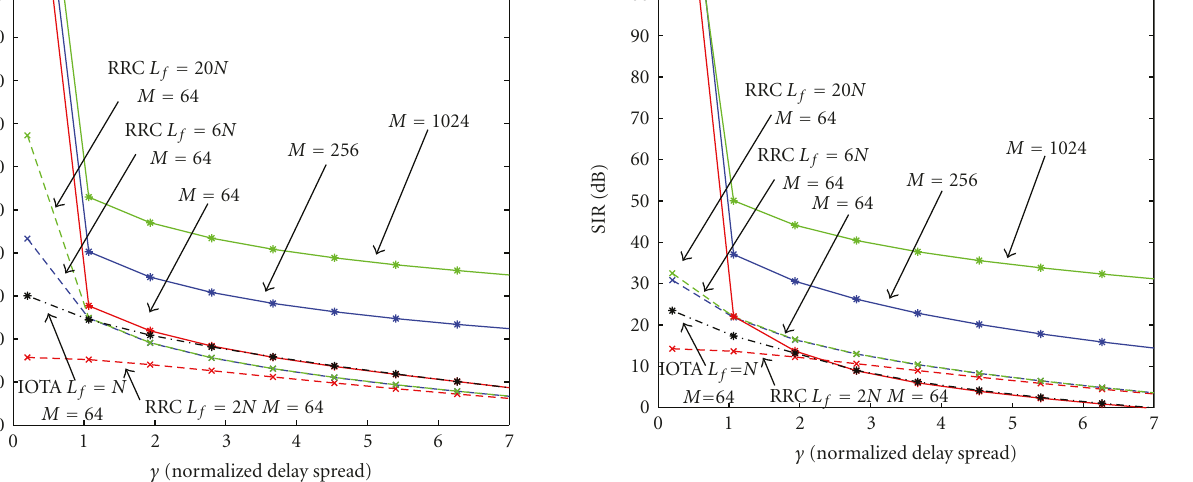
Figure 13: SIR versus the normalized delay spread γ for orthogonal pulse (solid lines) with M 0 = 2, N 0 = 3, and L f = N .